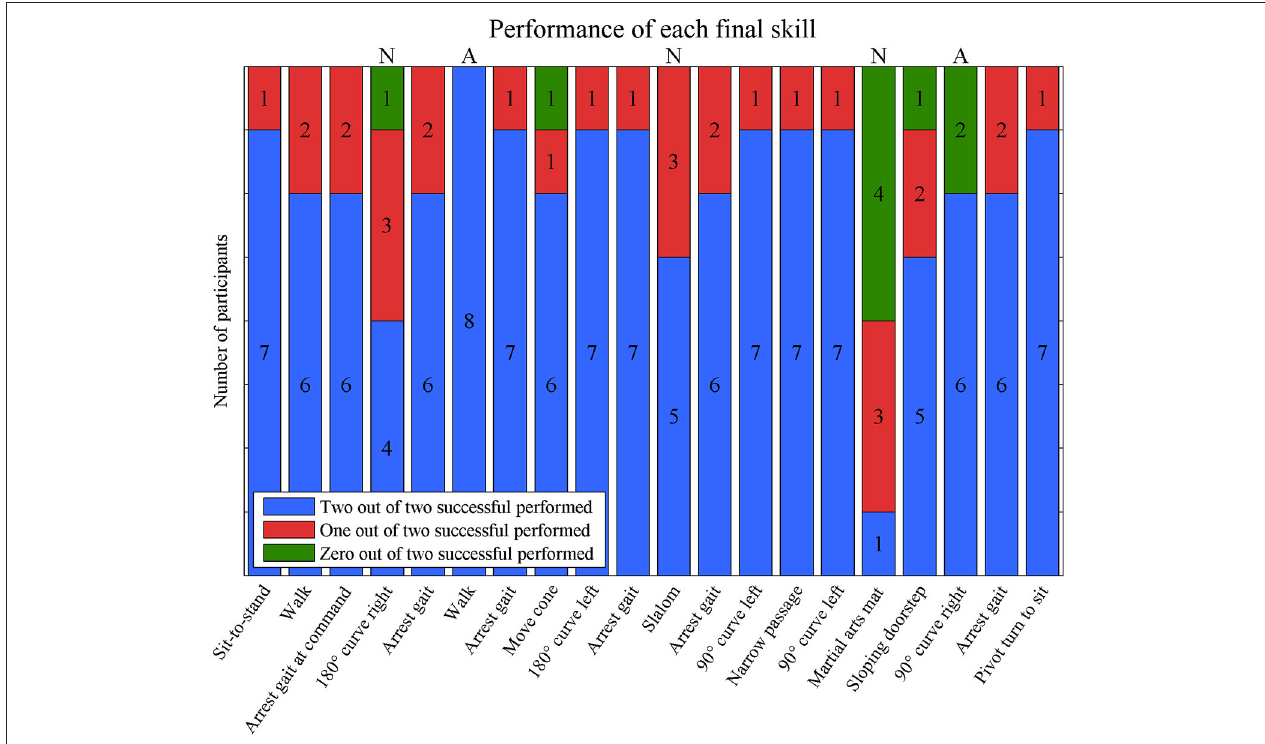
FIGURE 5 | The number of consistent performances of each final skill. Green bars represent inconsistent performances in which one out of two attempt was successful performed. Blue and red bars represent consistent performances. A = all performed consistent; N = < 70% performed consistent.